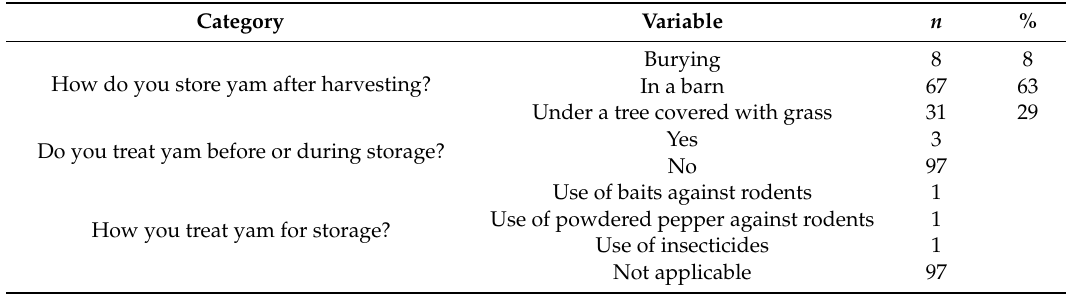
Table 3. Method of yam storage by